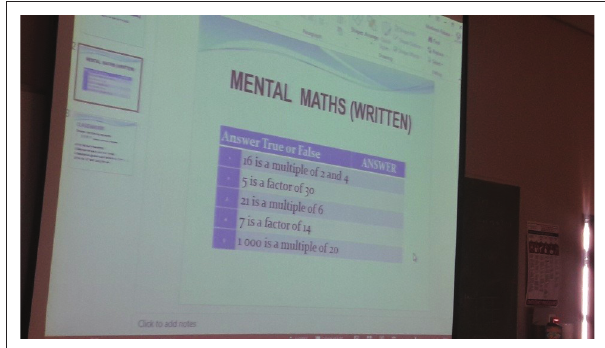
FIGURE 1: Activity 1 on mental maths.